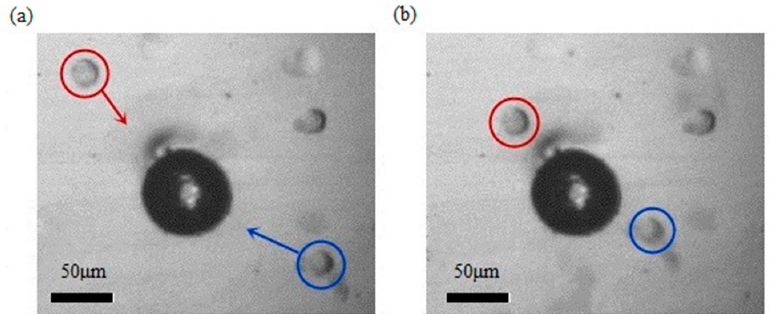
the activity of the cells was not affected after collection.